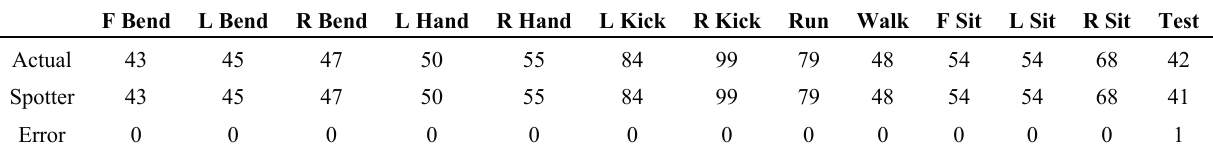
Table 2. Spotter model experimental results.